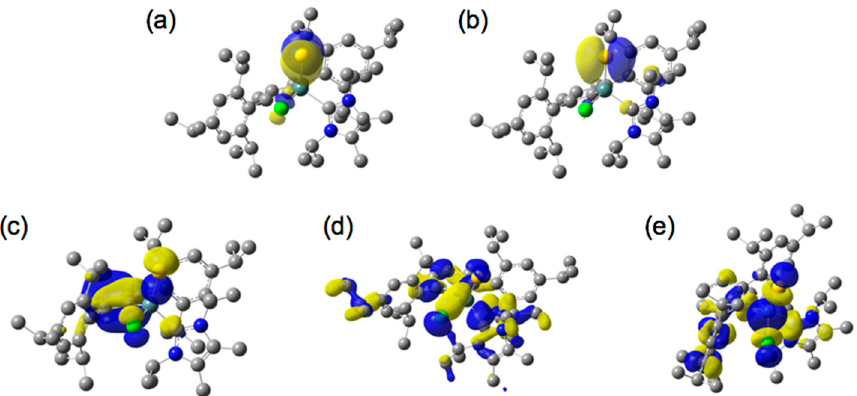
Figure 3. Selected molecular orbitals and their energy levels (eV): ( a ) HOMO ( − 4.815 eV), ( b ) HOMO − 1 ( − 4.925 eV), ( c ) HOMO − 7 ( − 6.6529 eV), ( d ) HOMO − 29 ( − 9.1961 eV), ( e ) LUMO + 8 ( − 0.6615 eV).